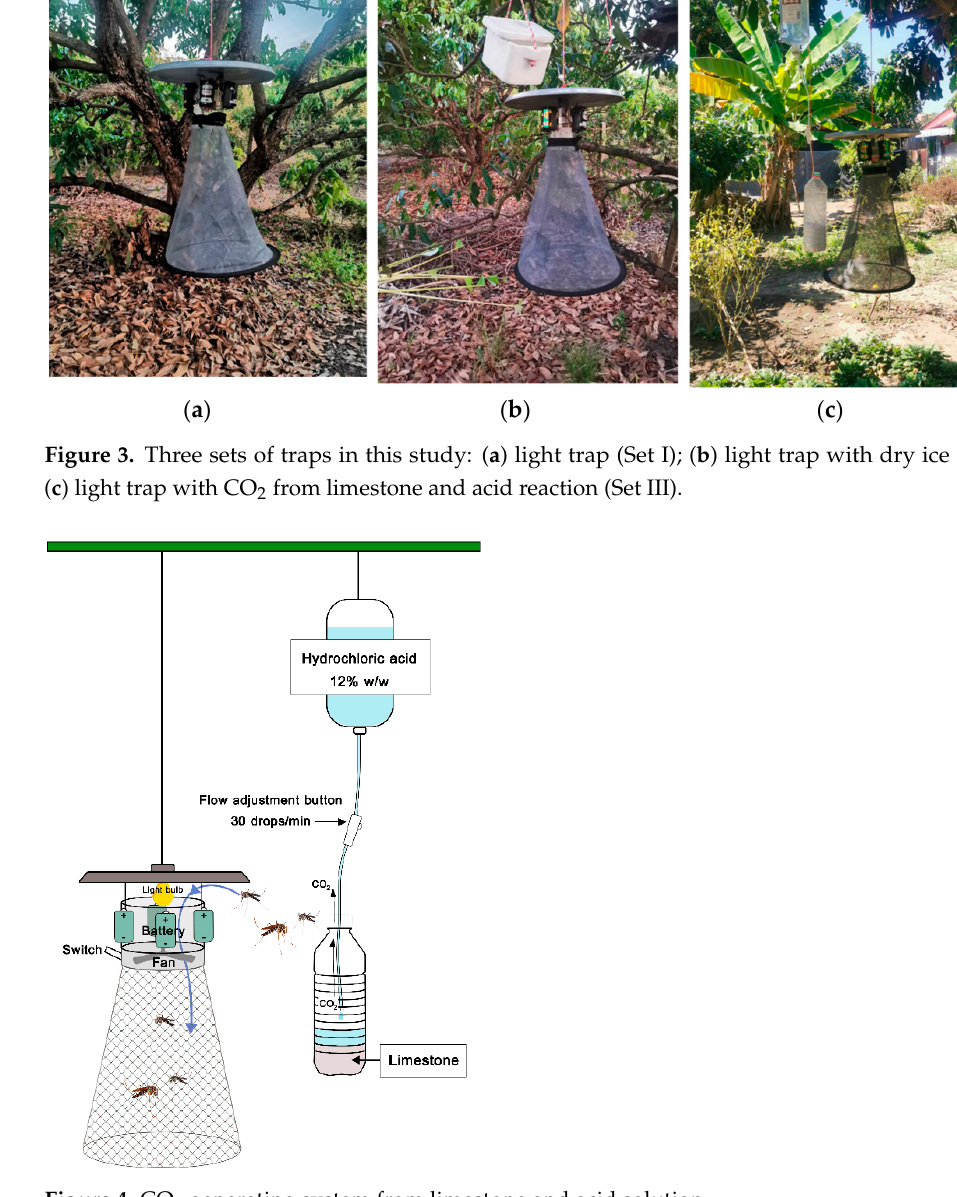
Figure 4. CO 2 generating system from limestone and acid